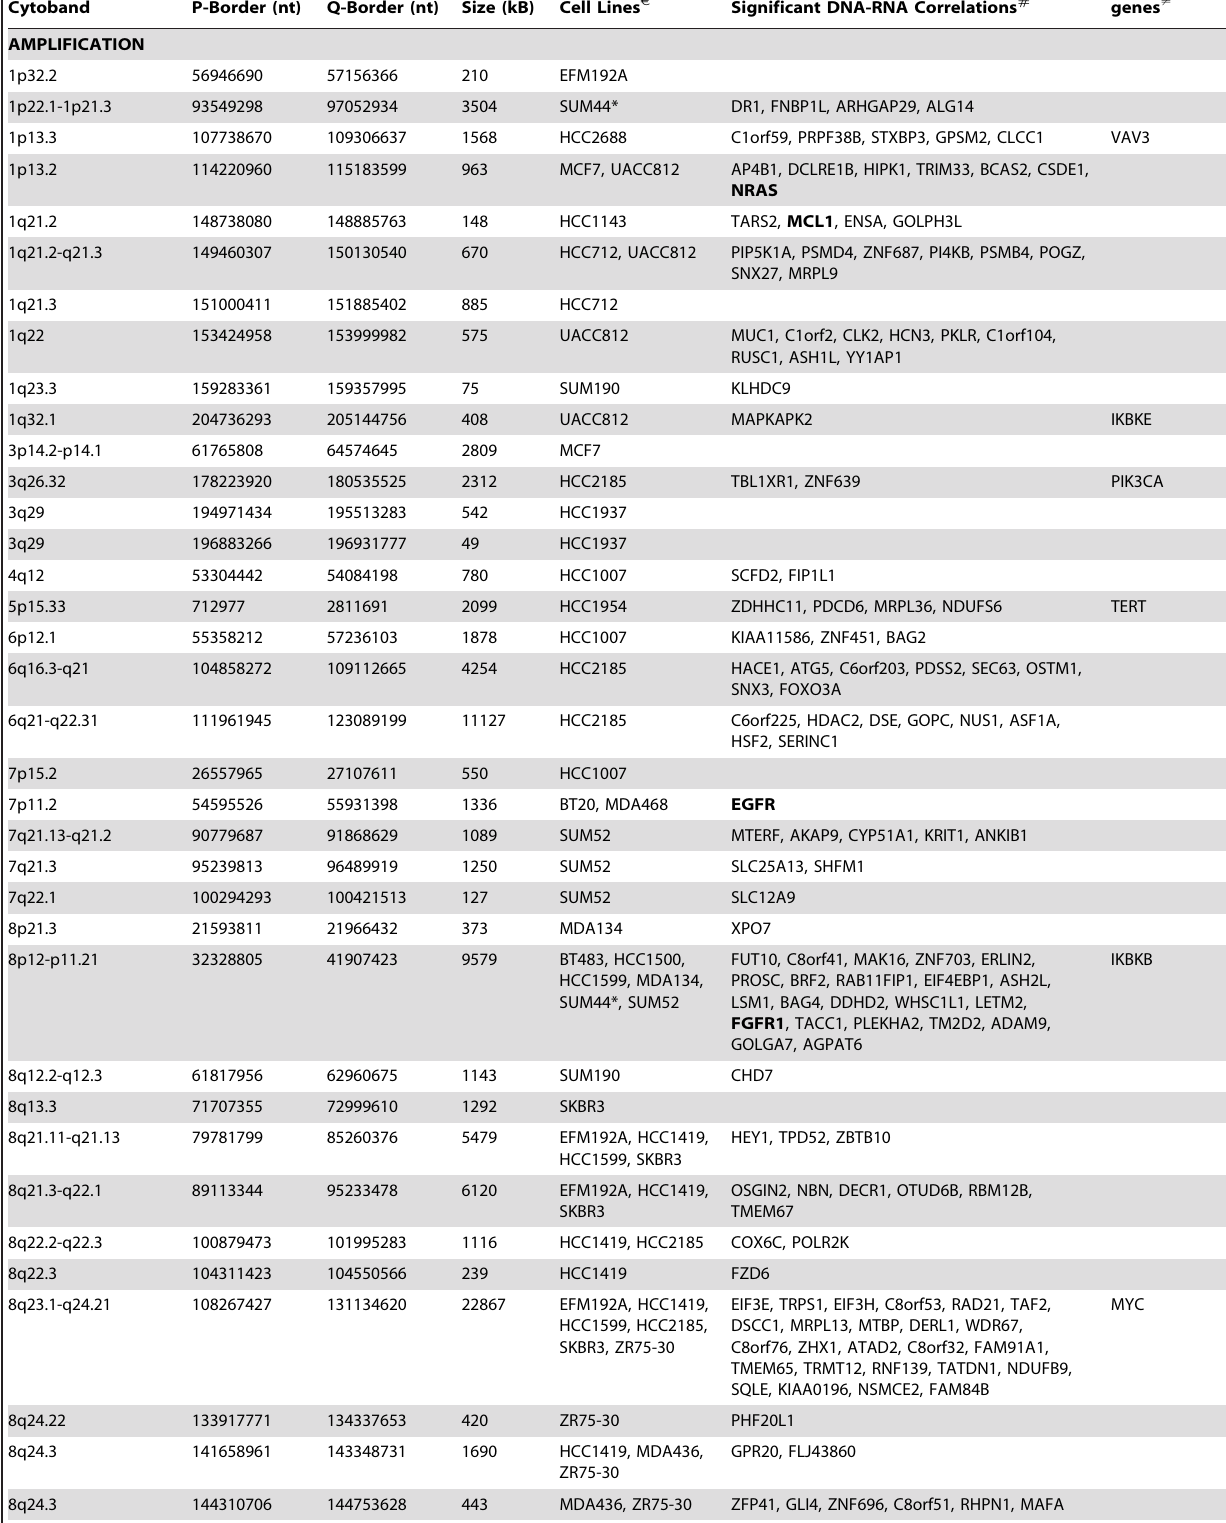
Cytoband P-Border (nt) Q-Border (nt) Size (kB) Cell Lines J Significant DNA-RNA Correlations